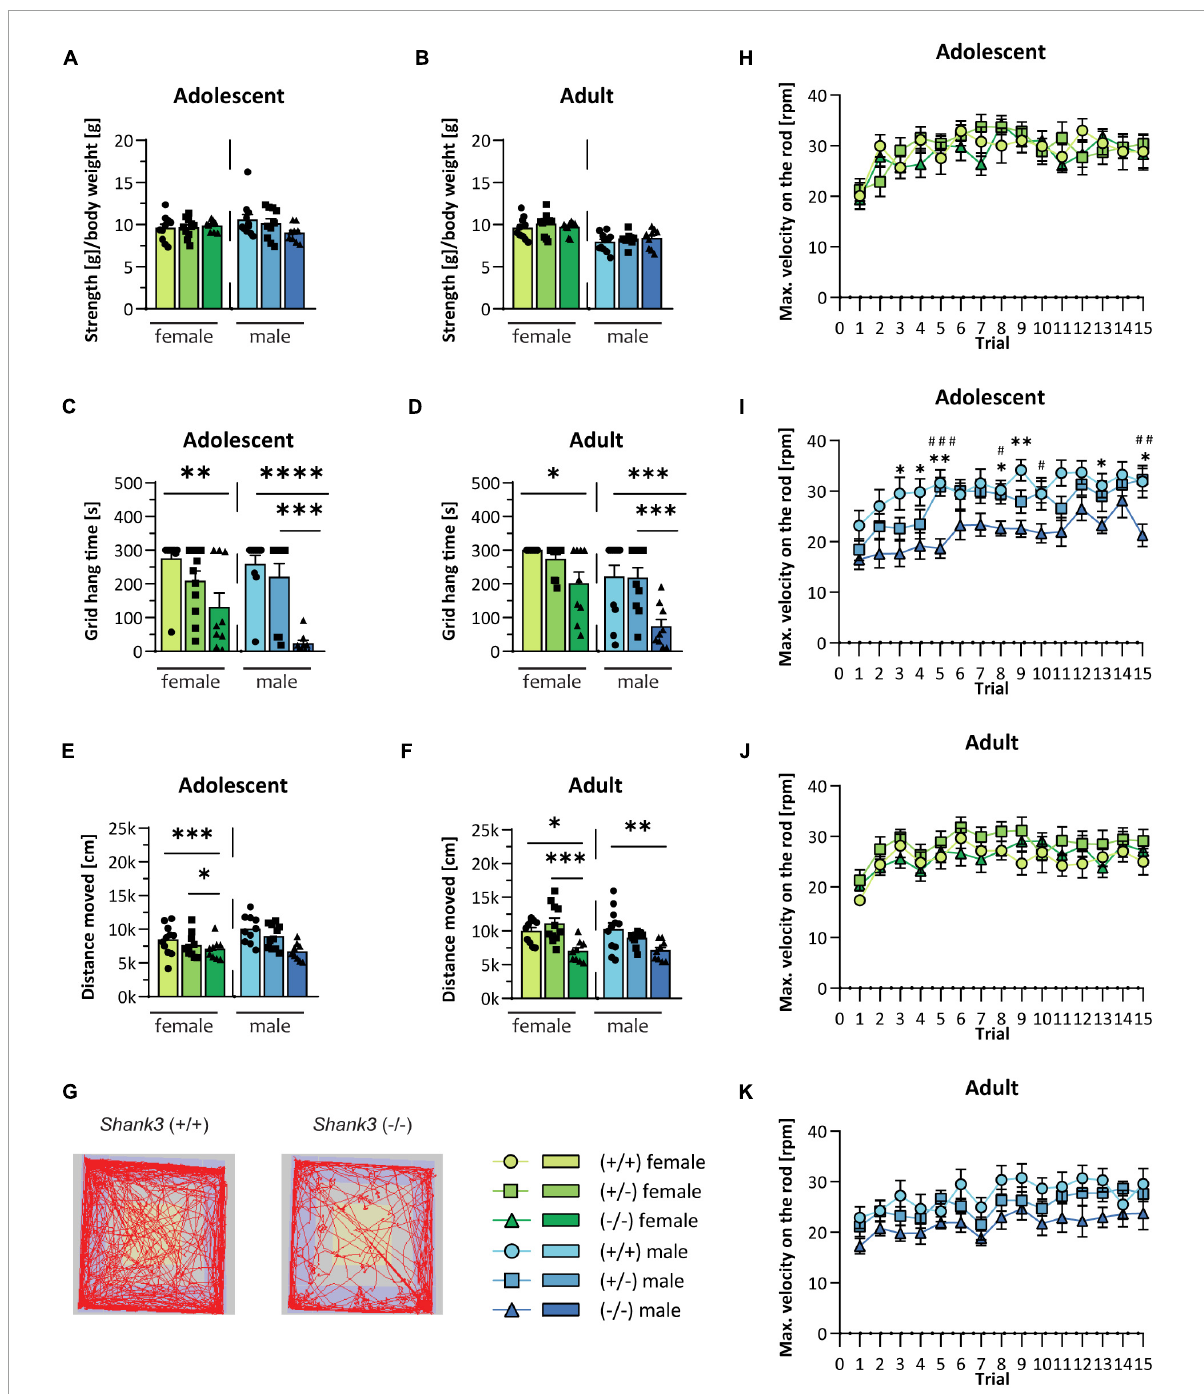
FIGURE1 Motor function in Shank3- transgenic mice. Muscle function is analyzed in male and female wildtype, Shank3 (+/–), and Shank3 (–/–) mice at adolescent and adult age by determining (A,B) the muscle strength and (C,D) the grid hang time in the grid hanging test. (E,F) General locomotion was measured as the distance moved during a 30 min trial in the open field test. (G) Representative tracking images of the open field test from a wildtype and a Shank3 (–/–) mouse are displayed. Motor memory and coordination were tested in three trials per day on five consecutive days on the accelerating Rotarod (4 to 40 rotations per minute within 5 min). (H–K) The maximal velocity, when the animal fell from the rod, is displayed. Asterisks ( ∗ ) indicate significant differences between wildtype and Shank3 (–/–) mice; # indicates significant differences between Shank3 (+/–) and Shank3 (–/–) mice. All data are represented as means with SEM with 9–11 animals per group. Significance levels ( p -values) are set to 0.05 ( p ≤ 0.05 ∗ / # , p ≤ 0.01 ∗∗ / ## , p ≤ 0.001 ∗∗∗ / ### , p ≤ 0.0001 ∗∗∗∗ ) with 95% confidence interval. See Supplementary Table 2 for detailed statistical